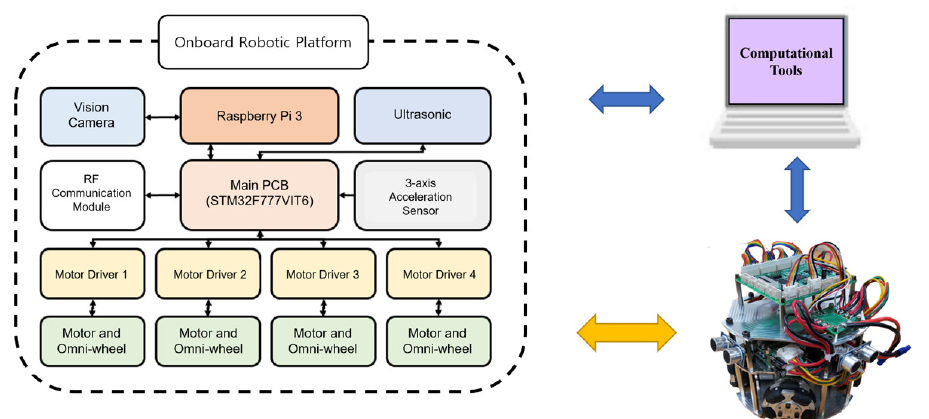
Figure 6. Entire communication architecture of the developed